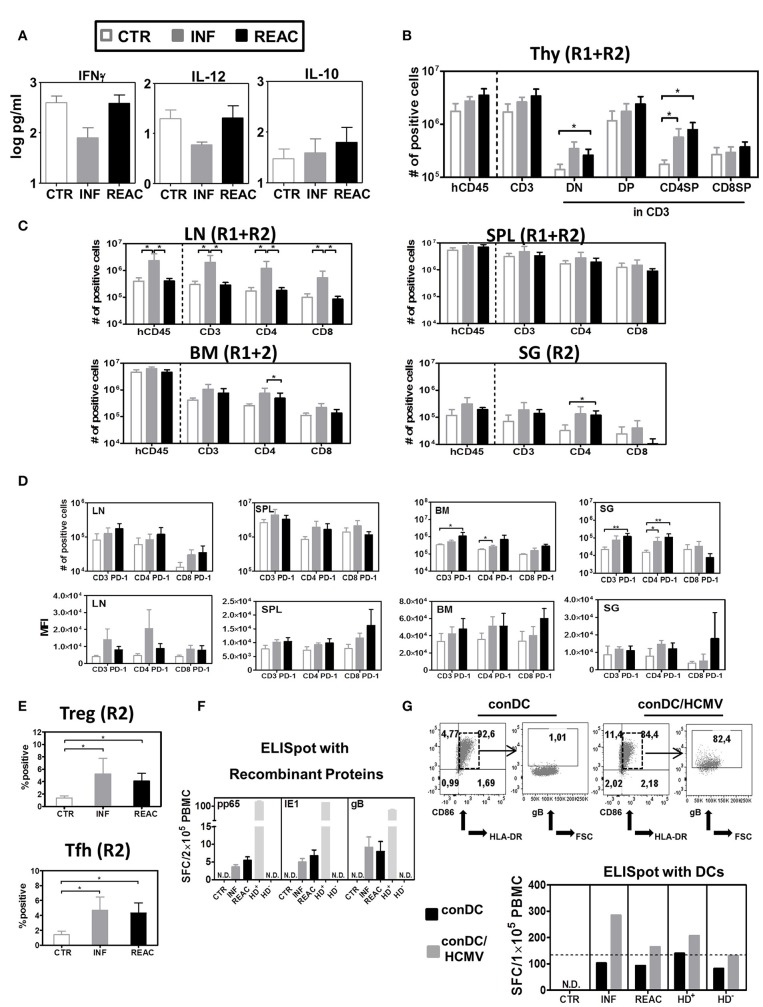
Detection of human cytokines, T cell distribution in different lymphatic and non-lymphatic tissues plus, TREGs, T-FH and functional T cell responses against HCMV. (A) Luminex bead-array obtained concentration (pg/ml) of human IFN-γ, IL-12, and IL-10 in mouse plasma. (B) Quantified total cell numbers (# of positive cells) of huCD45+ cells within all lymphocytes, CD3+ T cells within huCD45+, and DN, DP, CD4SP, and CD8SP within CD3+ T cells. (C) Quantified total cell numbers (# of positive cells) of huCD45+ cells within all lymphocytes, CD3+ T cells within huCD45+, and CD4+ and CD8+ within CD45+ T cells for SPL, LN, BM, and SG. Bar graphs represent CTR (white bars), INF (gray bars), and reactivated (REAC, black bars) mice. Reconstitutions included in analysis are indicated (R1+R2: CTR n = 7, INF n = 8, REAC n = 8; R2: CTR n = 3, INF n = 4, REAC n = 4). Error bars represent standard error of the mean. Negative binomial-regression model was applied for statistical analysis (* < 0.05). (D) Total cell numbers (# of positive cells) (top panel) and mean fluorescent intensity (MFI, bottom panel) for PD-1 expression on CD3+, CD4+, and CD8+ T cells in SPL (R1+R2), LN (R2), BM (R2), and SG (R2). Negative binomal-regression model was applied for statistical analysis (* < 0.05; ** < 0.01). (E) Top Panel: Percentage of FoxP3+/CD45RA− regulatory T cells; lower panel: Percentage of PD-1+/CXCR5+ FTh cells in SPL of individual mice analyzed in R2 corresponding to CTR (white dots), INF (gray dots), and REAC (black dots). One-way ANOVA with Turkey test was used for statistical analysis (* < 0.05). (F) IFN-γ ELISpot assay performed with cells recovered from BM (Exp.4) stimulated with proteins. BM samples from mice in each cohort (CTR n = 3, INF n = 3 and REAC n = 3) were stimulated in duplicates with HCMV pp65, HCMV IE1 and HCMV gB recombinant proteins. N.D. depicts non-detectable spots. An HCMV sero-positive donor (HD+) and a sero-negative (HD−) were used as references. Results are depicted in spot-forming cells (SFC) per 2 × 105 PBMC. (G) IFN-γ ELISpot assay performed with cells recovered from LN and mLN (Exp.4) were stimulated with HCMV-infected dendritic cells. Upper panels: Flow cytometry analyses of conventional DCs (conDC) or HCMV-infected conDC (con/HCMV) showing gB expression in the later. Lower panel: Pooled samples obtained from mice in each cohort were co-incubated with conDC or conDC/HCMV in duplicates. N.D. depicts non-detectable spots. HD+ and HD− were used as references. Results are depicted in SFC per 1 × 105 PBMC and bar graphs represent the mean values for duplicates.